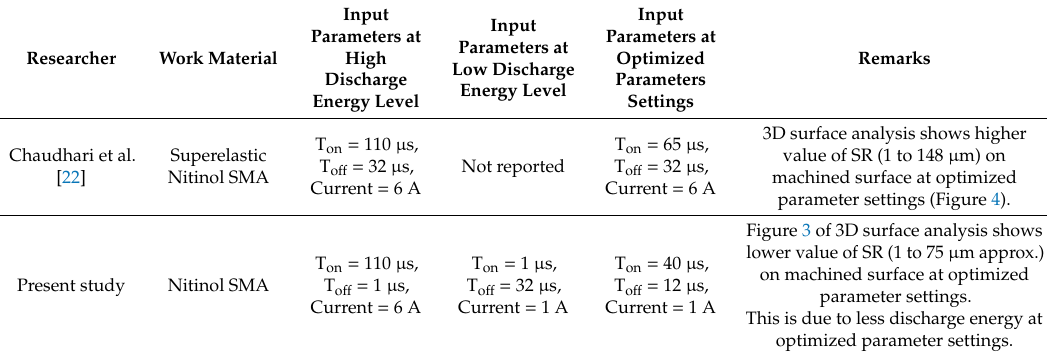
Table 2. 3D surface analysis comparison of present study with past study [22].